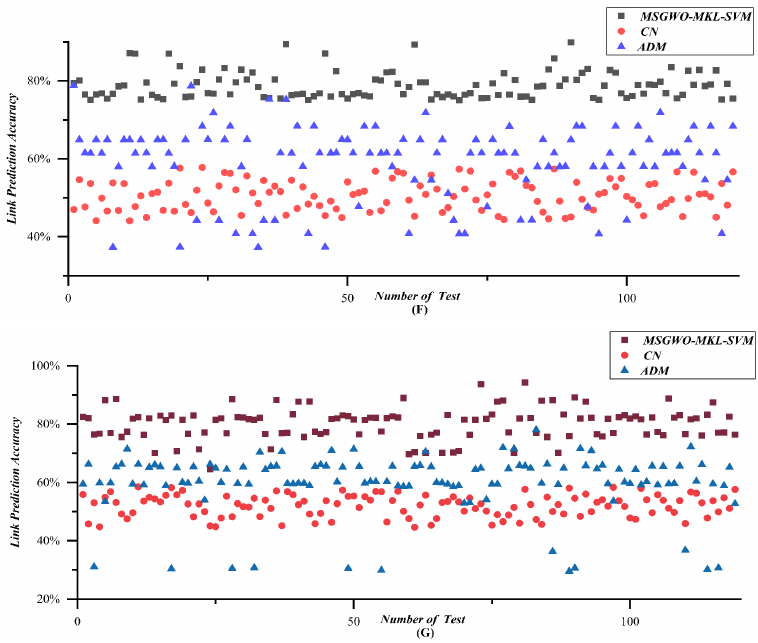
Figure 19. ( A – G ) Scatter diagrams of link prediction results. Table 5. Results of link